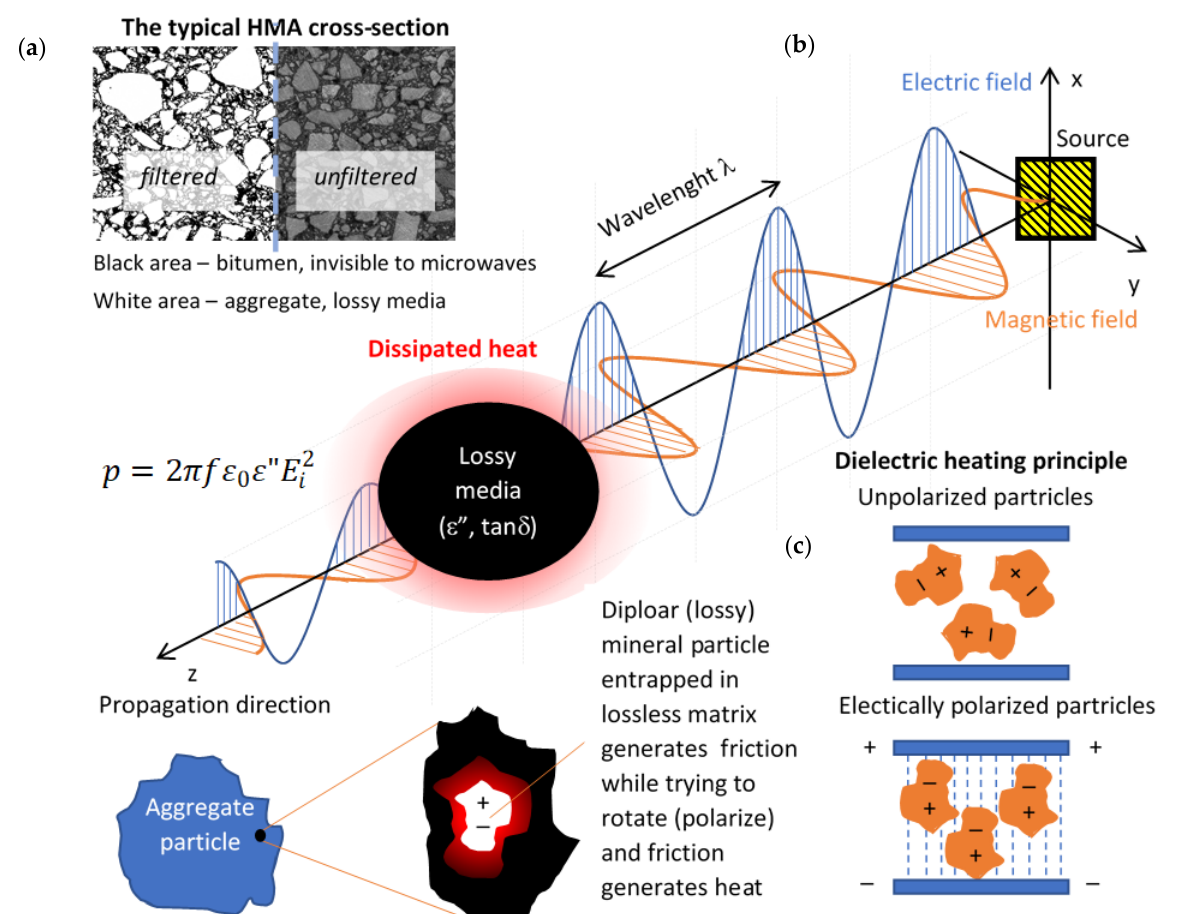
Figure 1. ( a ) HMA cross-section—white regions are capable of being dielectrically heated; ( b ) Microwave heating scheme (p—power density in Watts/m 3 , ε 0 —electric permittivity of the free-space, ε (cid:48)(cid:48) —dielectric loss constant, E i2 —mean square electric field intensity); ( c ) dielectric heating principle.